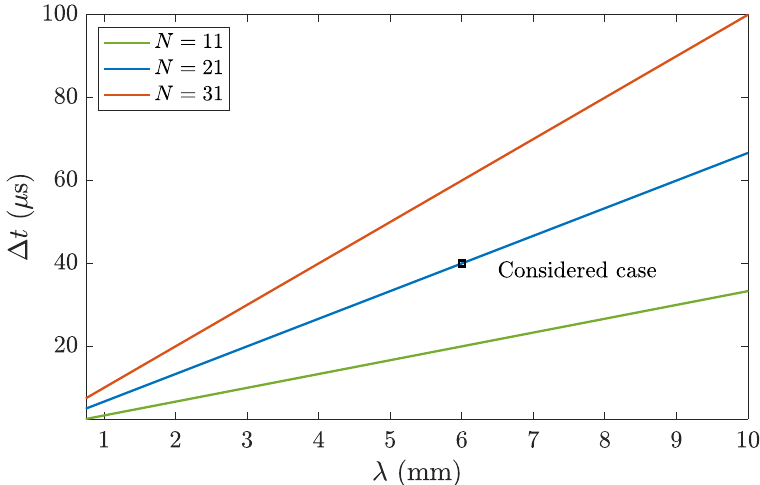
Figure 1. Transient state duration ∆ t as a function of the wavelength: N = 11 (green), N = 21 (blue), and N = 31